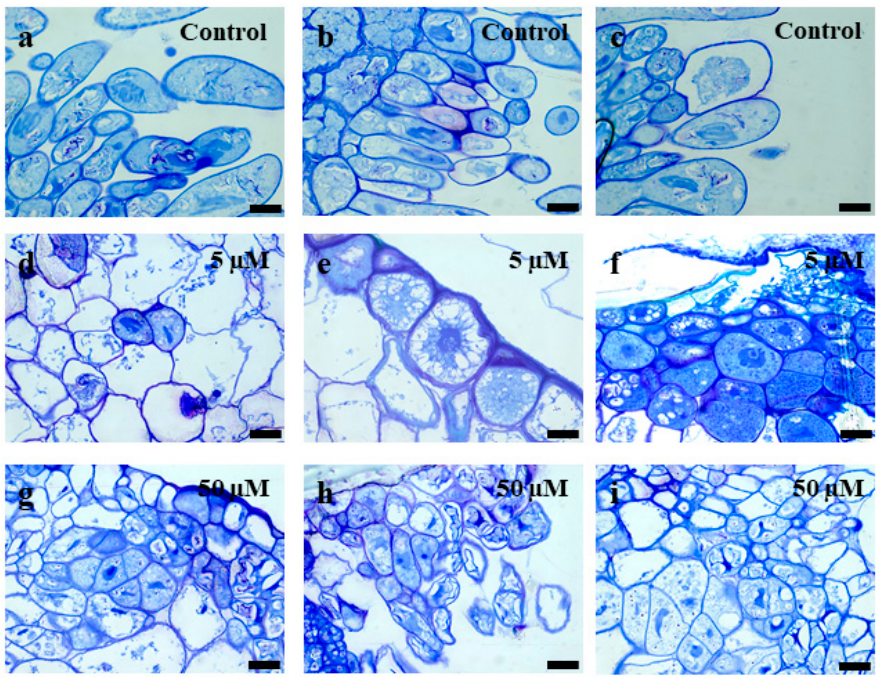
Figure A1. Histological sections of the Brachypodium callus stained with a 0.05% ( w / v ) toluidine blue O. ( a – c ): control callus; ( d – f ): callus that has been treated with 5 µM of 5-azaC. ( g – i ): callus that has been treated with 50 µM of 5-azaC. Scale bars, 10 µm.